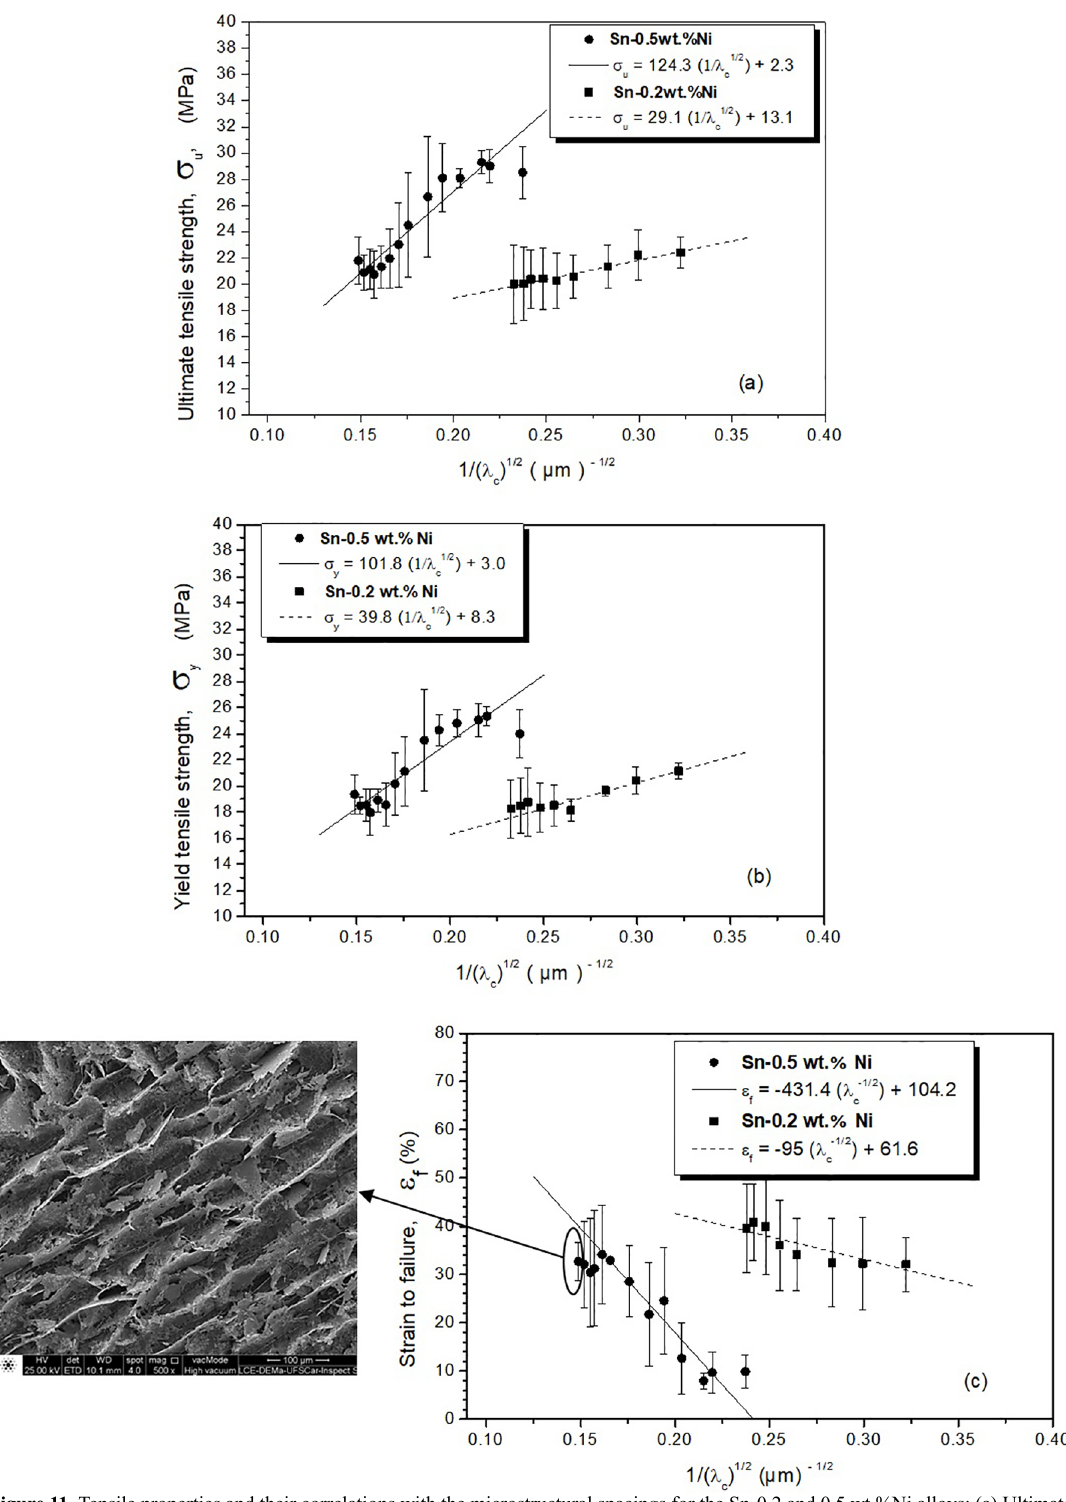
Figure 11. Tensile properties and their correlations with the microstructural spacings for the Sn-0.2 and 0.5 wt.%Ni alloys: (a) Ultimate tensile strength vs. (λ ) -1/2 ; (b) yield tensile strength vs. (λ c